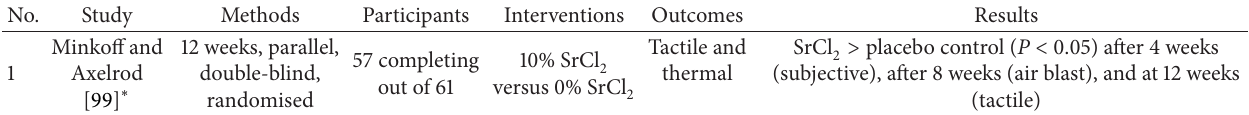
Table 3: Characteristics of the included Strontium containing toothpaste